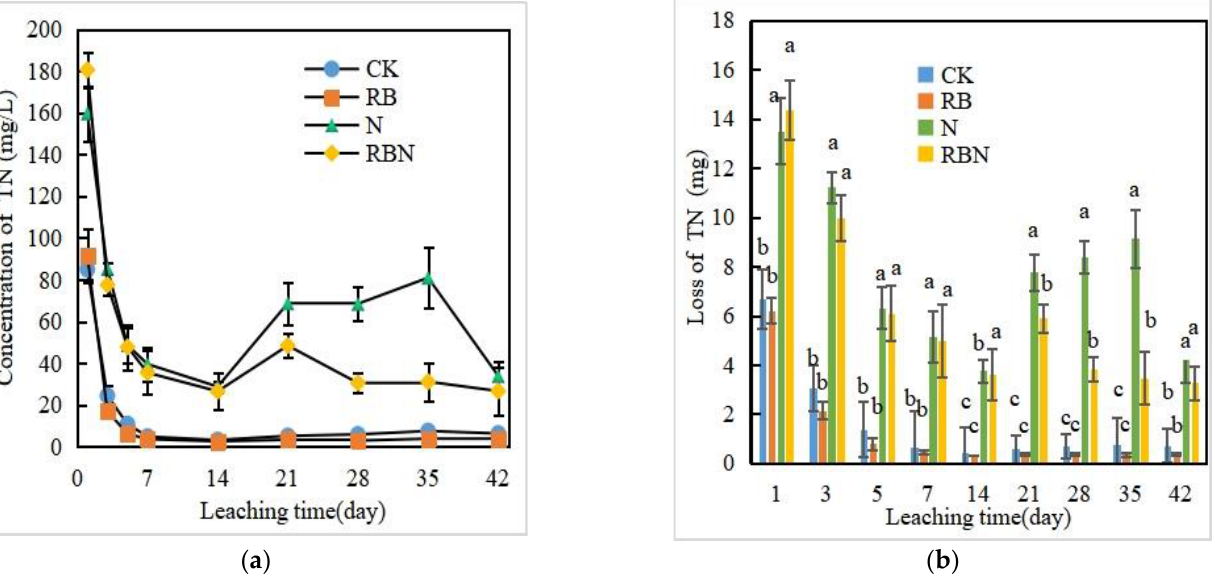
Figure 5. ( a ) Concentration of TN in leachate; ( b ) loss of TN in leachate. Different letters in the image (b) indicate significant differences between treatments (p < 0.05).